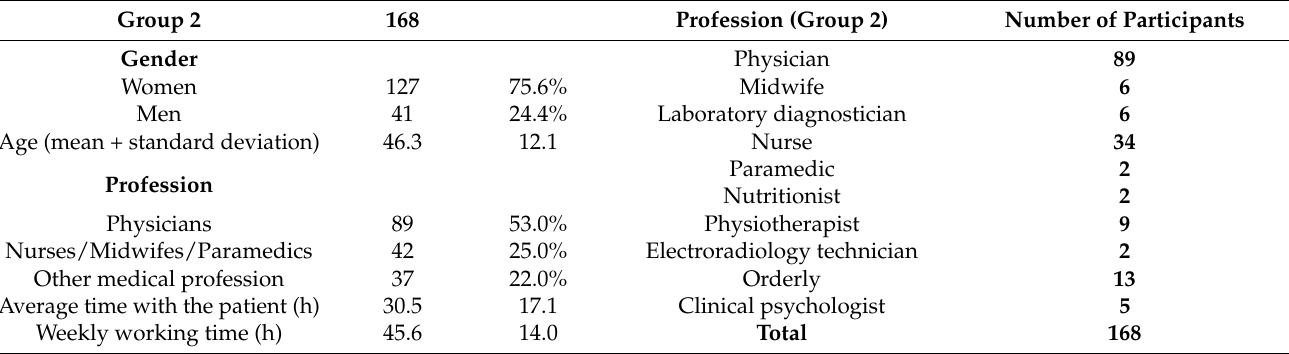
Table 5. Characteristics of group 2 with profession structure.